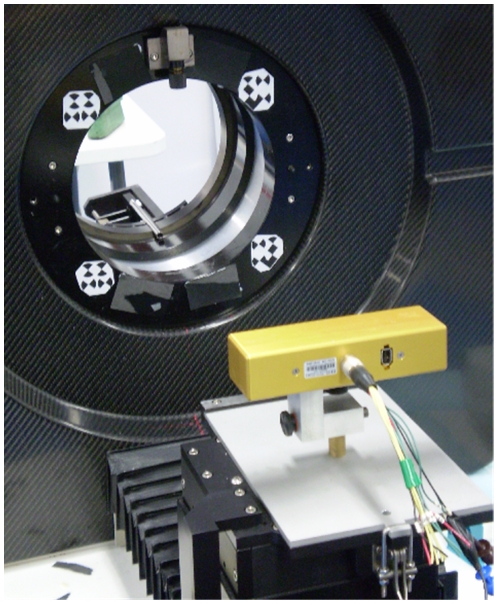
Setup for motion tracking.The MicronTracker stereo tracking system is shown here in the foreground attached to the scanner bed unit via a custom-made mount. In the background is the microPET scanner bore. A 4-part marker affixed to the scanner bore is used to define a reference coordinate system and enables changes in the relative pose of the tracker and scanner to be accounted for.